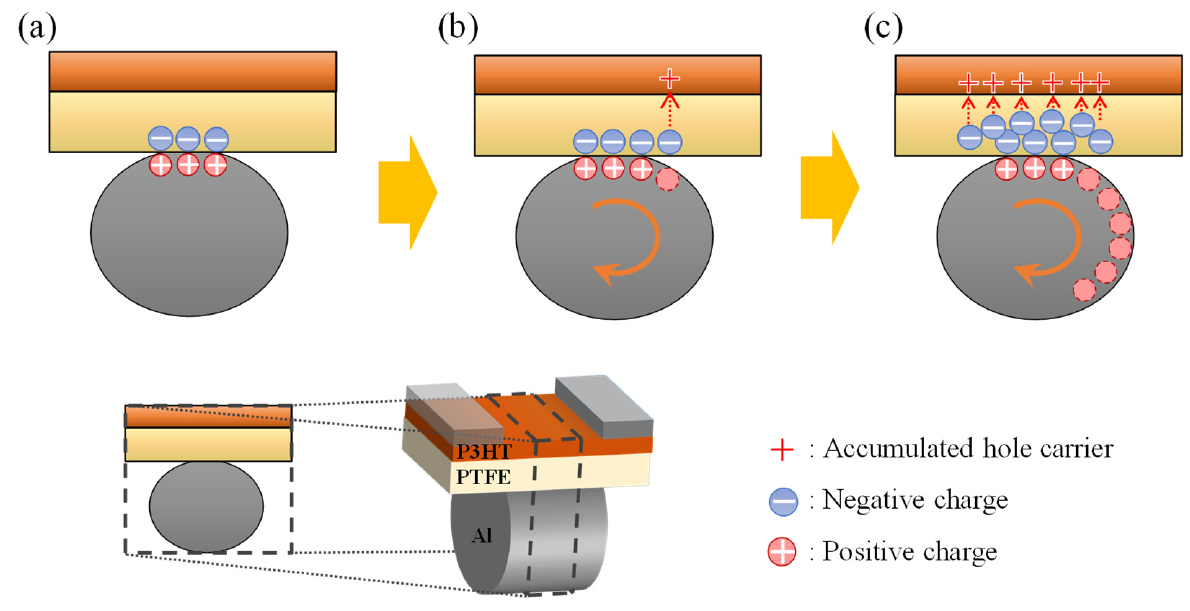
Figure 4. Theoretical schematic of channel generation by triboelectric charging in the fabricated RGT. ( a ) The Al gate and gateless device first contact, ( b ) the gate starts to rotate in the direction of the orange arrow and ( c ) rotates at high velocity. The circular plus (+) and minus ( − ) signs indicate the positive and negative charges generated via triboelectric charging by the rotating gate, respectively. The hole carriers induced by the negative charge (dotted arrow) of PTFE and accumulated at the semiconductor–insulator interface on the P3HT side are indicated by plus signs.